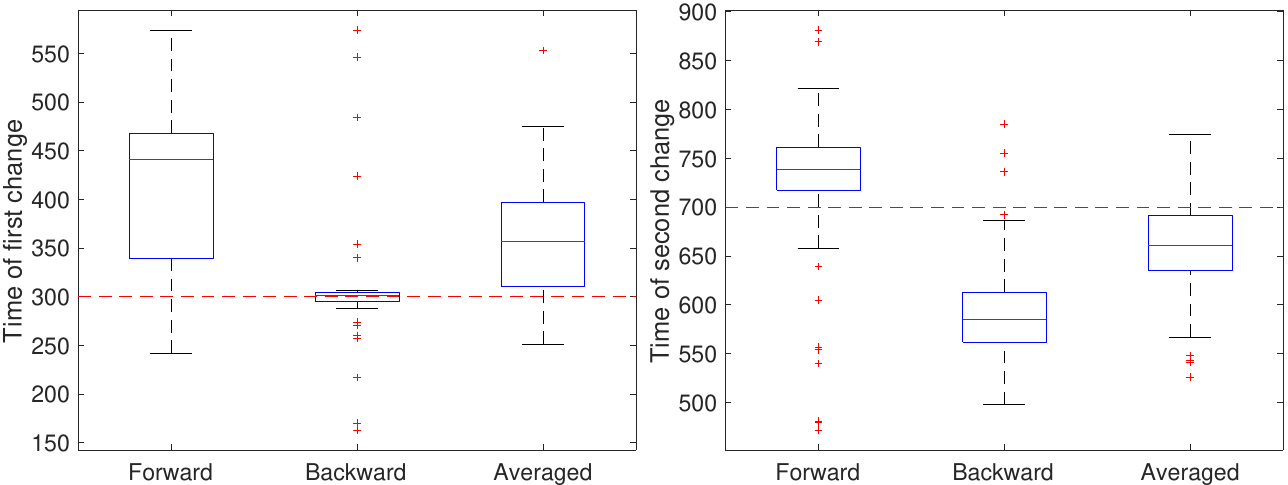
Figure 5. Detected time of change under a high noise setting based on using only the forward pass, only the backward pass, or averaging the two. ( left ) Estimates of the time of the first change (at k = 300) of the parameter a from a value of 1 to 0.8 and ( right ) estimates of the time of the second change (at k = 700 ) back to